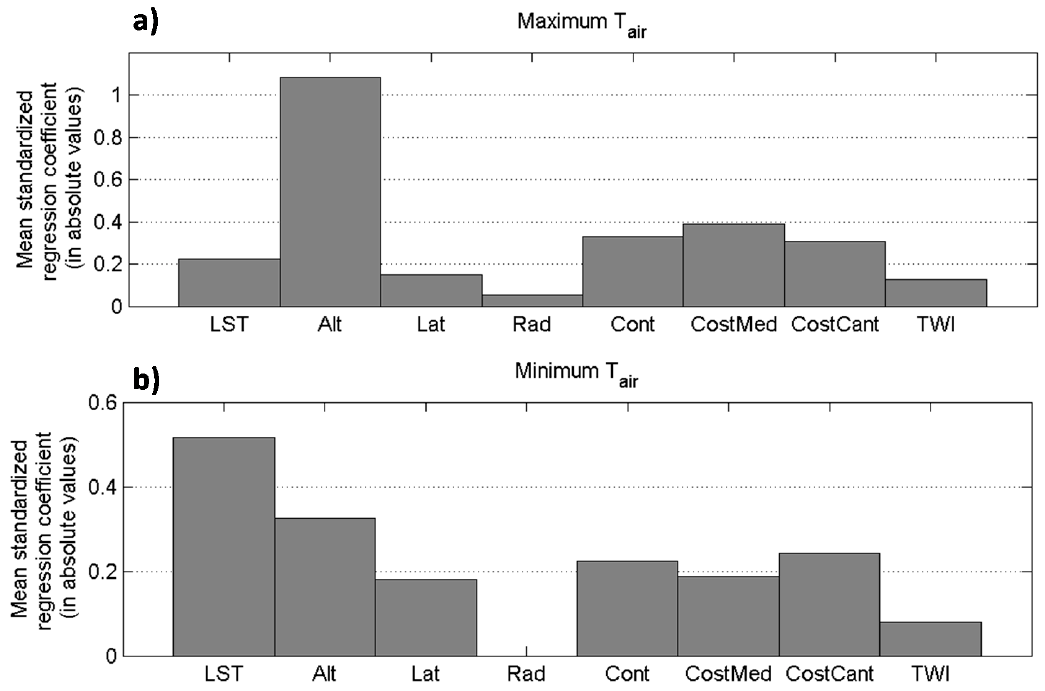
Figure 10. Mean value for the standardized regression coefficients (in absolute values) obtained for the month-to-month maximum ( a ) and minimum ( b ) T air estimates, by considering all years, months, and meteorological stations for models including the LST product indicated in Figure 3. Alt.: altitude; Lat.: latitude; Rad: potential solar radiation; Cont.: continentality; CostMed and CostCant: cost distance to the Mediterranean Sea or Cantabric Sea, respectively; TWI: topographic wetness index.